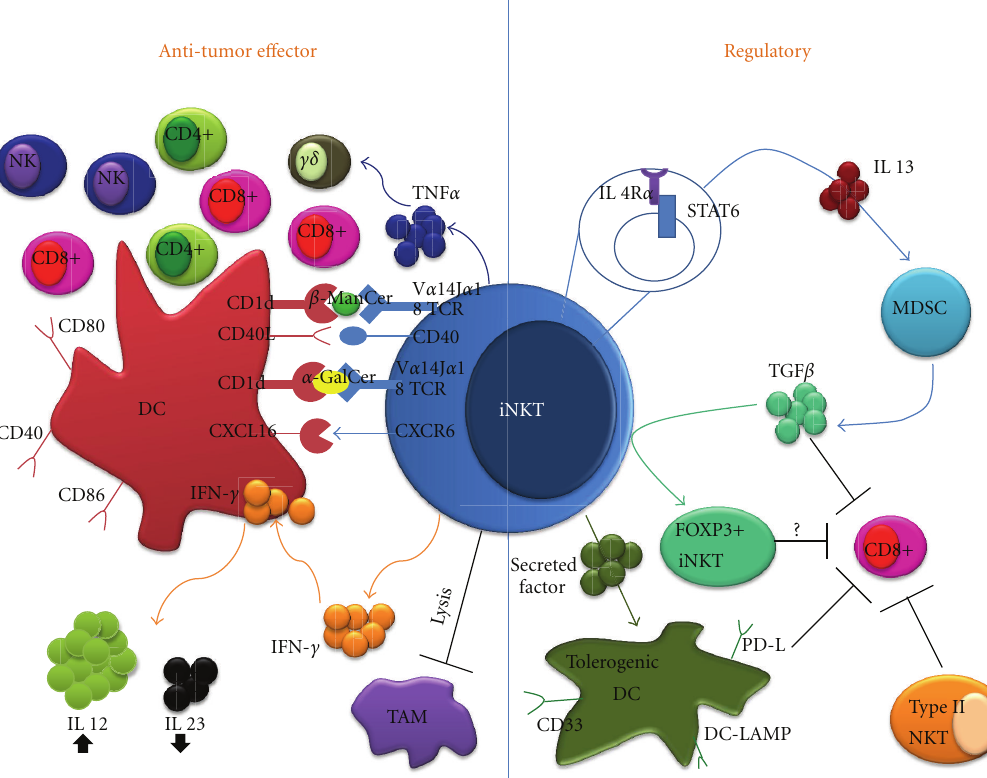
Figure 1: In cancer, iNKT cells play a dual role that can promote (left) or suppress (right) the antitumor immune response. In the presence of a strong activator ( α -GalCer), iNKT cells promote the ability of DCs to prime e ff ector cells through IL-12 production and upregulation of costimulatory molecules. Ligation of CD40L on the surface of DCs provides positive feedback enhancing iNKT cell activation. These events ultimately lead to downstream activation of antitumor e ff ectors such as NK cells, CD8+, and CD4+ T-cells. Other iNKT agonists ( β -ManCer) stimulate TNF- α production, leading to activation of antitumor γδ T-cells. iNKT cells may also promote antitumor immunity by directly killing protumorigenic macrophages (TAMs). On the other hand, IL-13 production by iNKT cells can trigger TGF- β production by suppressive MDSCs. TGF- β directly inhibits e ff ector CD8+ activity and can induce FoxP3 expression in iNKT cells. iNKT cells can also induce DCs to acquire a tolerogenic phenotype, including expression of DC-LAMP, PD-L, and CD33. Data suggest that type II NKT cells perform always immunosuppressive functions in